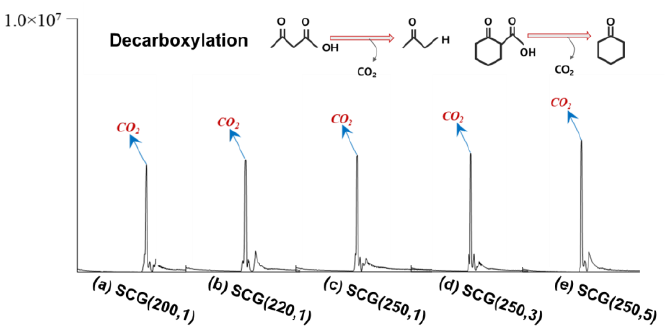
Figure 6. CO 2 peak intensity by Py-GC/MS.